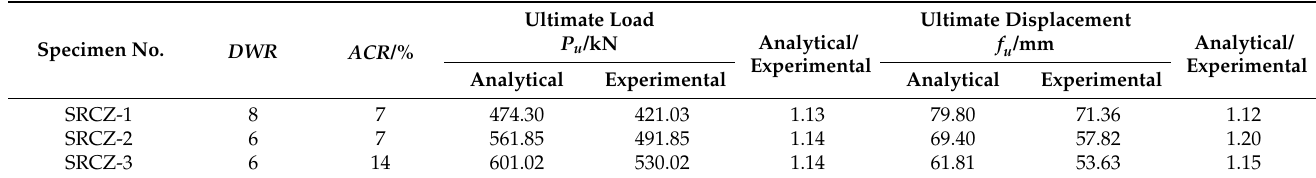
Table 5. The Comparison of the Analytical and Experimental Results.